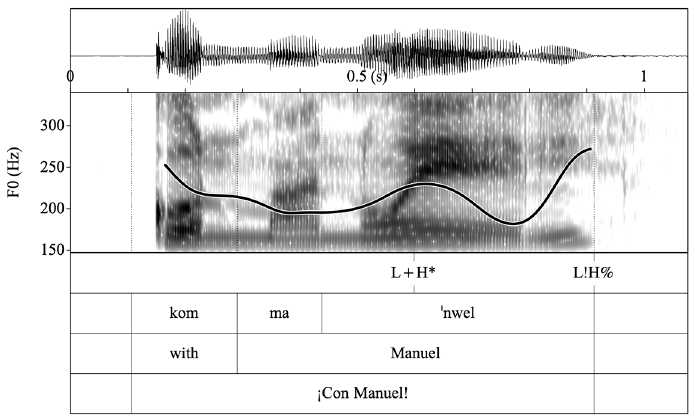
Figure 8. Waveform, spectrogram and F0 trace of the statement of the obvious To Manuel! in L1 Spanish produced with L+H* L!H%.